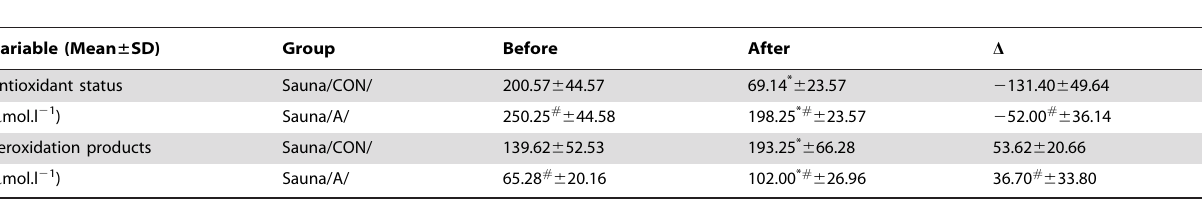
Table 4. Changes in concentration of lipid peroxidation products and antioxidant status in blood plasma in CON and A subjects during sauna